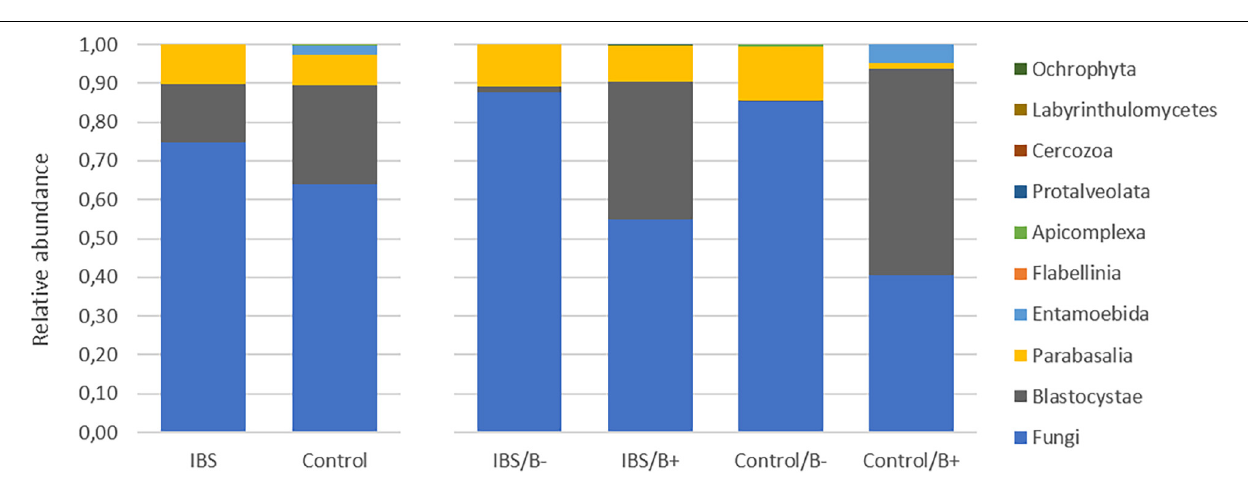
FIGURE 5 | Comparison of the fecal eukaryotic microbiota composition between controls and IBS subjects at the class level. IBS/B-: Blastocystis -negative IBS patients; IBS/B + : Blastocystis -positive IBS patients; Control/B-: Blastocystis -negative control subjects; Control/B + : Blastocystis -positive control